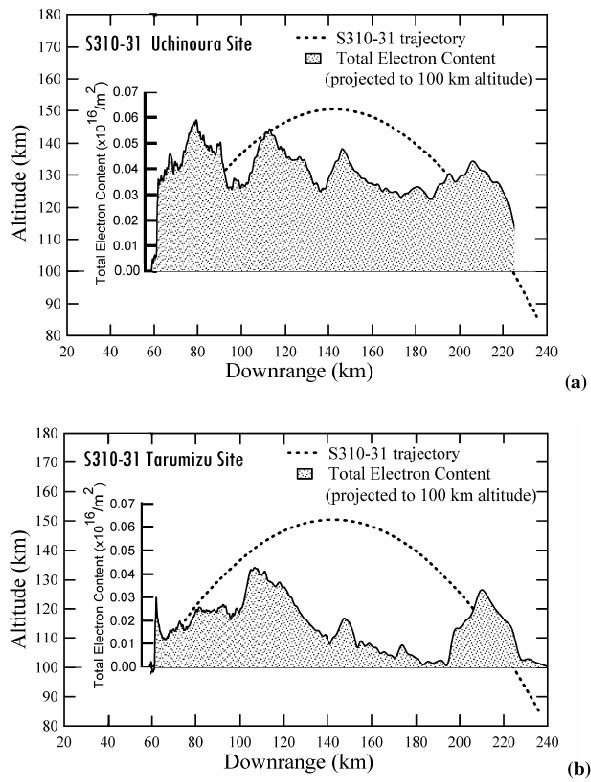
Fig. 9. (a) Projection of the TEC values to the 100km altitude (ob- tained by the Uchinoura site). Periodical and horizontal modulation of TEC occurs. The scale size of the plasma clouds is estimated to be about 30–40km. (b) Same as (a) except for the Tarumizu site. The scale size of the plasma clouds is estimated to be about 20-50km.